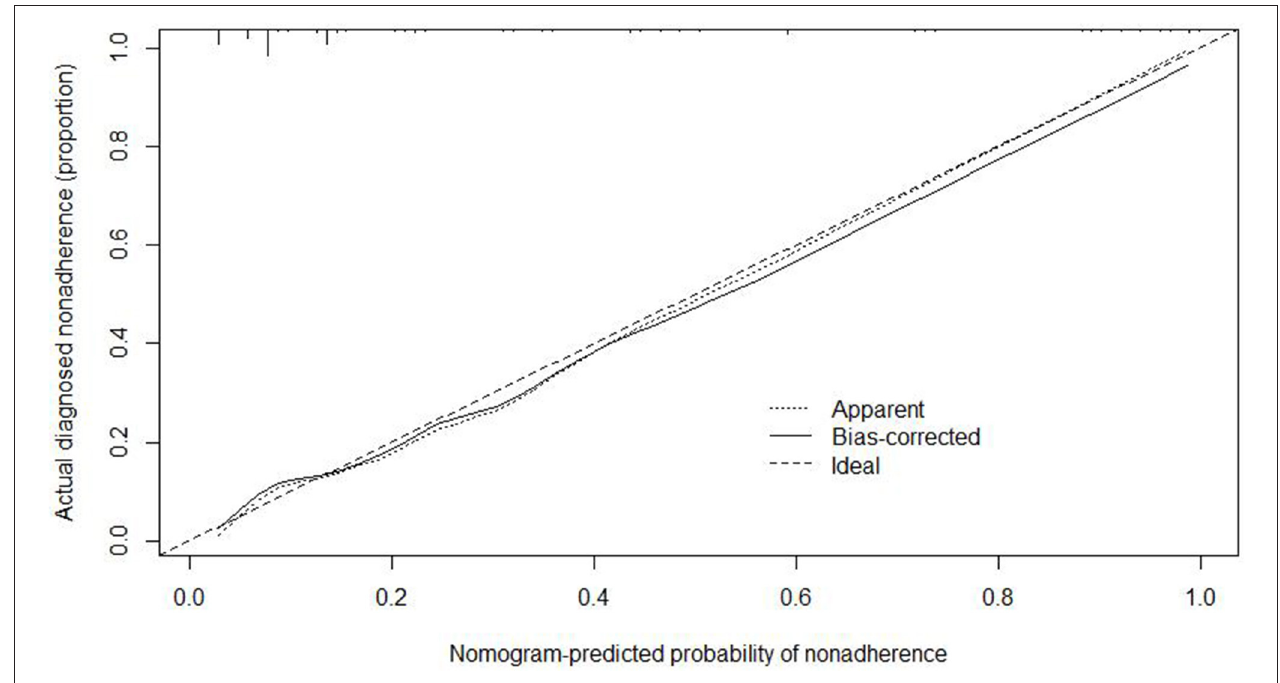
FIGURE 4 | Calibration curve of this nomogram